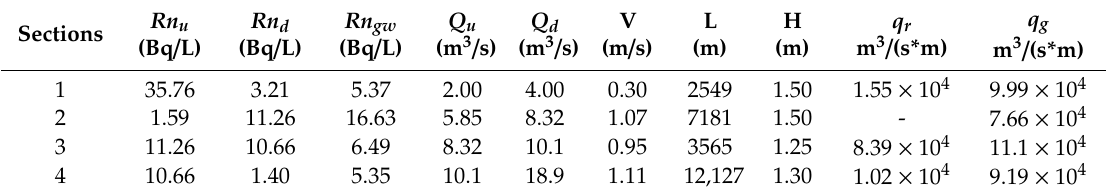
Table 3. Characteristics of the estimated sections and the calculated results obtained using the 222 Rn mass balance